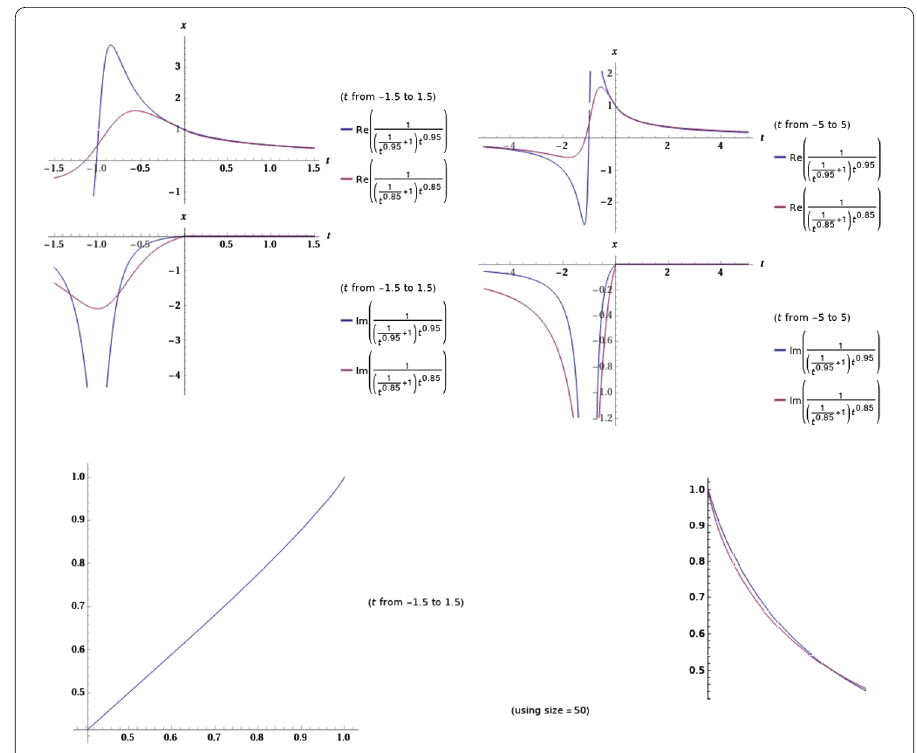
Figure 2 The optimal values of the controller at the fractional parameters ν = 0.85 and μ =